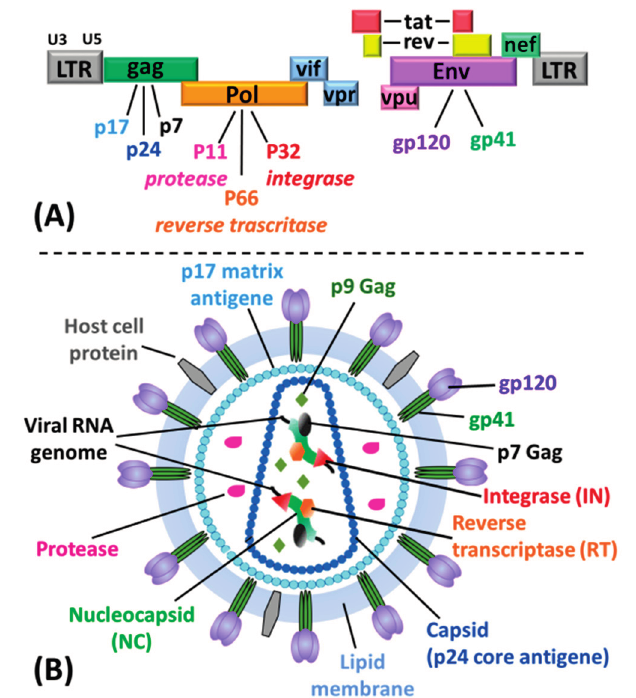
Figure 2. ( A ) HIV genome; ( B ) structure of a HIV virion particle with indication of the potential antiviral